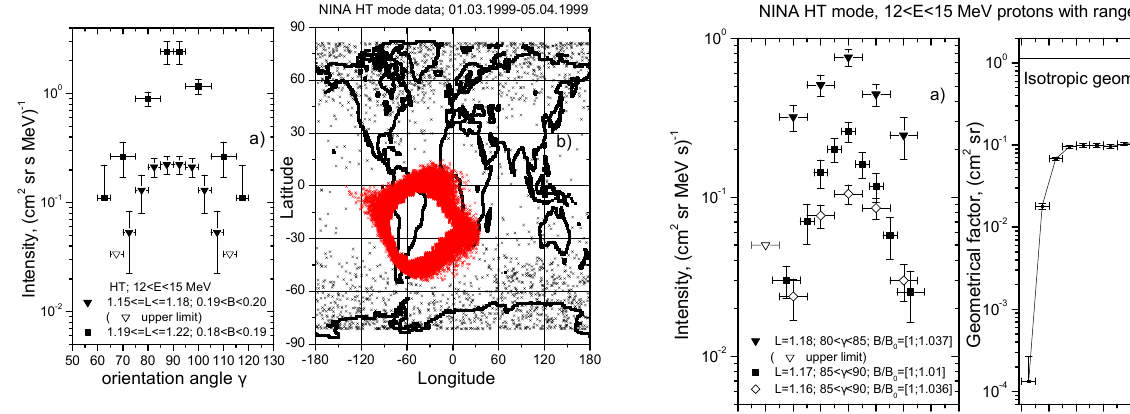
Fig.1 Fig. 1. (a) Pitch angle distributions of 12 < E < 15MeV protons im- pinging NINA from a radial direction for different (B, L) bins. (b) Geographical positions where the pitch angle distributions in panel Fig. 2. (a) Equator pitch angle distribution of 12 < E < 15MeV pro- (a) have been measured (red signs). Fig.2 tons with a range more than 3 views impinging NINA from the whole F.O.V. for different L-shells (width of each L-bin is 0.01). (b) Geometrical factor as a function of a proton’s pitch angle for orien- tation angle γ =87.5 ◦ , for a pitch angle step 5 ◦ and for the energy range 12–15MeV, which was used to reconstruct the fluxes. The isotropic geometrical factor for those protons is also shown (solid line).